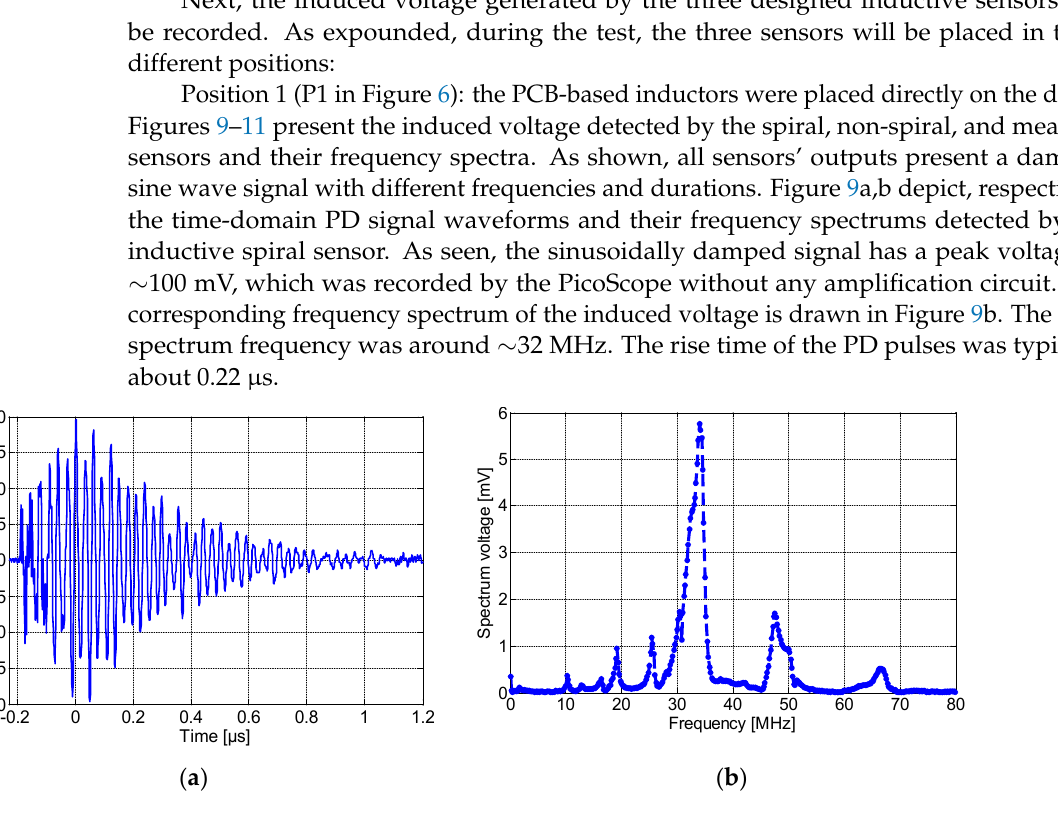
Figure 9. ( a ) The time-domain wave due to partial discharges at 8.2 kV, and ( b ) its frequency spectrum, detected by the inductive spiral sensor placed at P1.